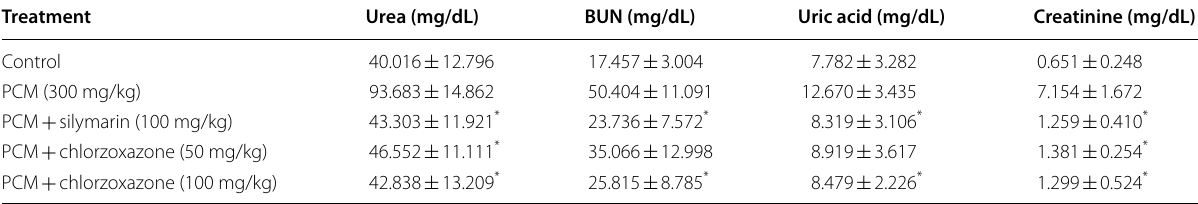
Urea, BUN, uric acid, and creatinine; All values are Mean different at p < 0.05, from paracetamol group